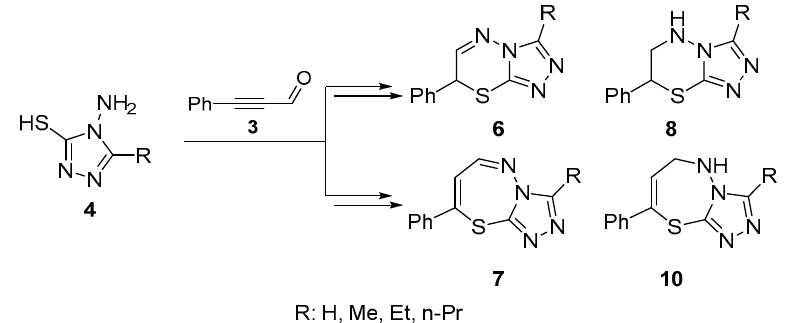
Figure 4. The proposed synthetic routes for target compounds: [1,2,4]triazolo[3,4- b ][1,3,4]thiadiazines 6 , 8 and [1,2,4]triazolo[3,4- b ][1,3,4]thiadiazepines 7 , 10 .